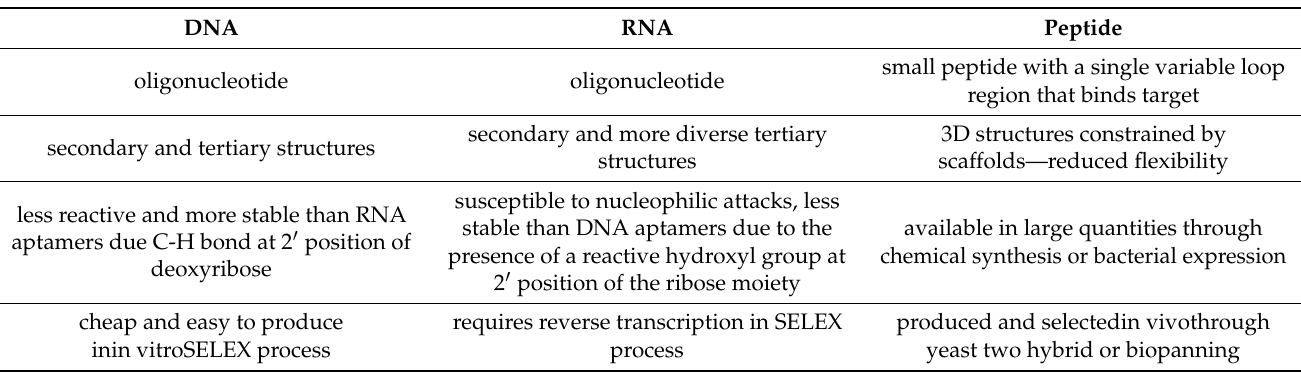
Table 1. Comparison of